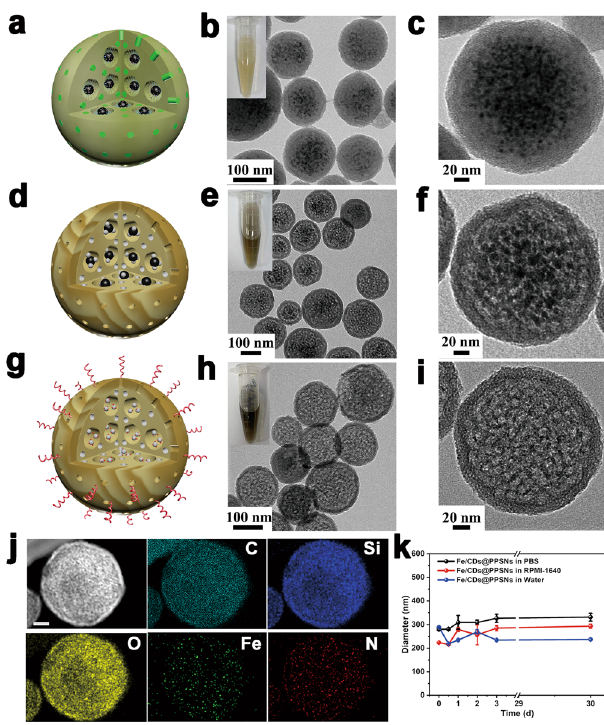
Fig. 2 Characterizations of Fe/CDs@PPSNs. Schematic diagram, TEM images and digital photographs (up-left insert) of ( a – c ) Fe 3 O 4 @PSNs precursor, ( d – f ) IOs/CDs@PSNs, and ( g – i ) Fe/CDs@PPSNs. j STEM-EDS element mappings (C, Si, O, Fe, N) of Fe/CDs@PPSNs (Scale bar = 50 nm). k Stability of Fe/CDs@PPSNs in RPMI-1640, PBS and water for 30 days. The data are expressed as means ± s. d. from three independent (Supplementary Fig. 10), Fe single atoms in the Fe/CDs@PPSNs exhibit high stability, and no leaching of ferrous or ferric ions can be detected even incubated in a mild acidic environment for 3 days (Fig. 3h, i) due to the strong binding ability of Fe-N bonds in the pore channels.